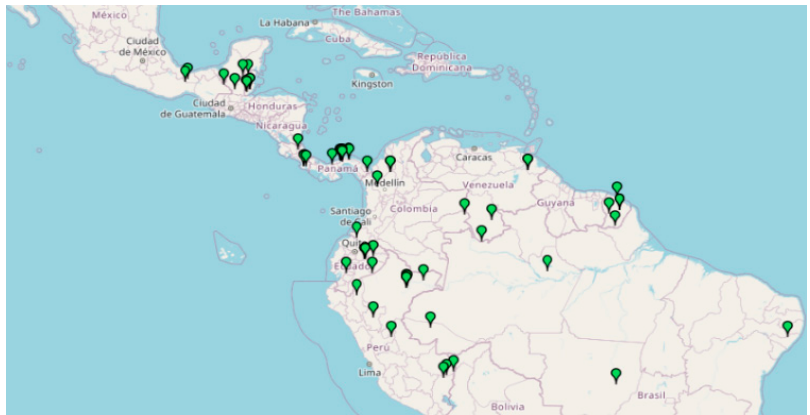
Figure 1. Distribution of A. spruceanum in Belize, Bolivia, Brazil, Colombia, Costa Rica, Ecuador, French Guiana, Guatemala, Guyana, Honduras, Mexico, Nicaragua, Panama, Perú, Suriname and Venezuela (retrieved from Missouri Botanical Garden, 2020).